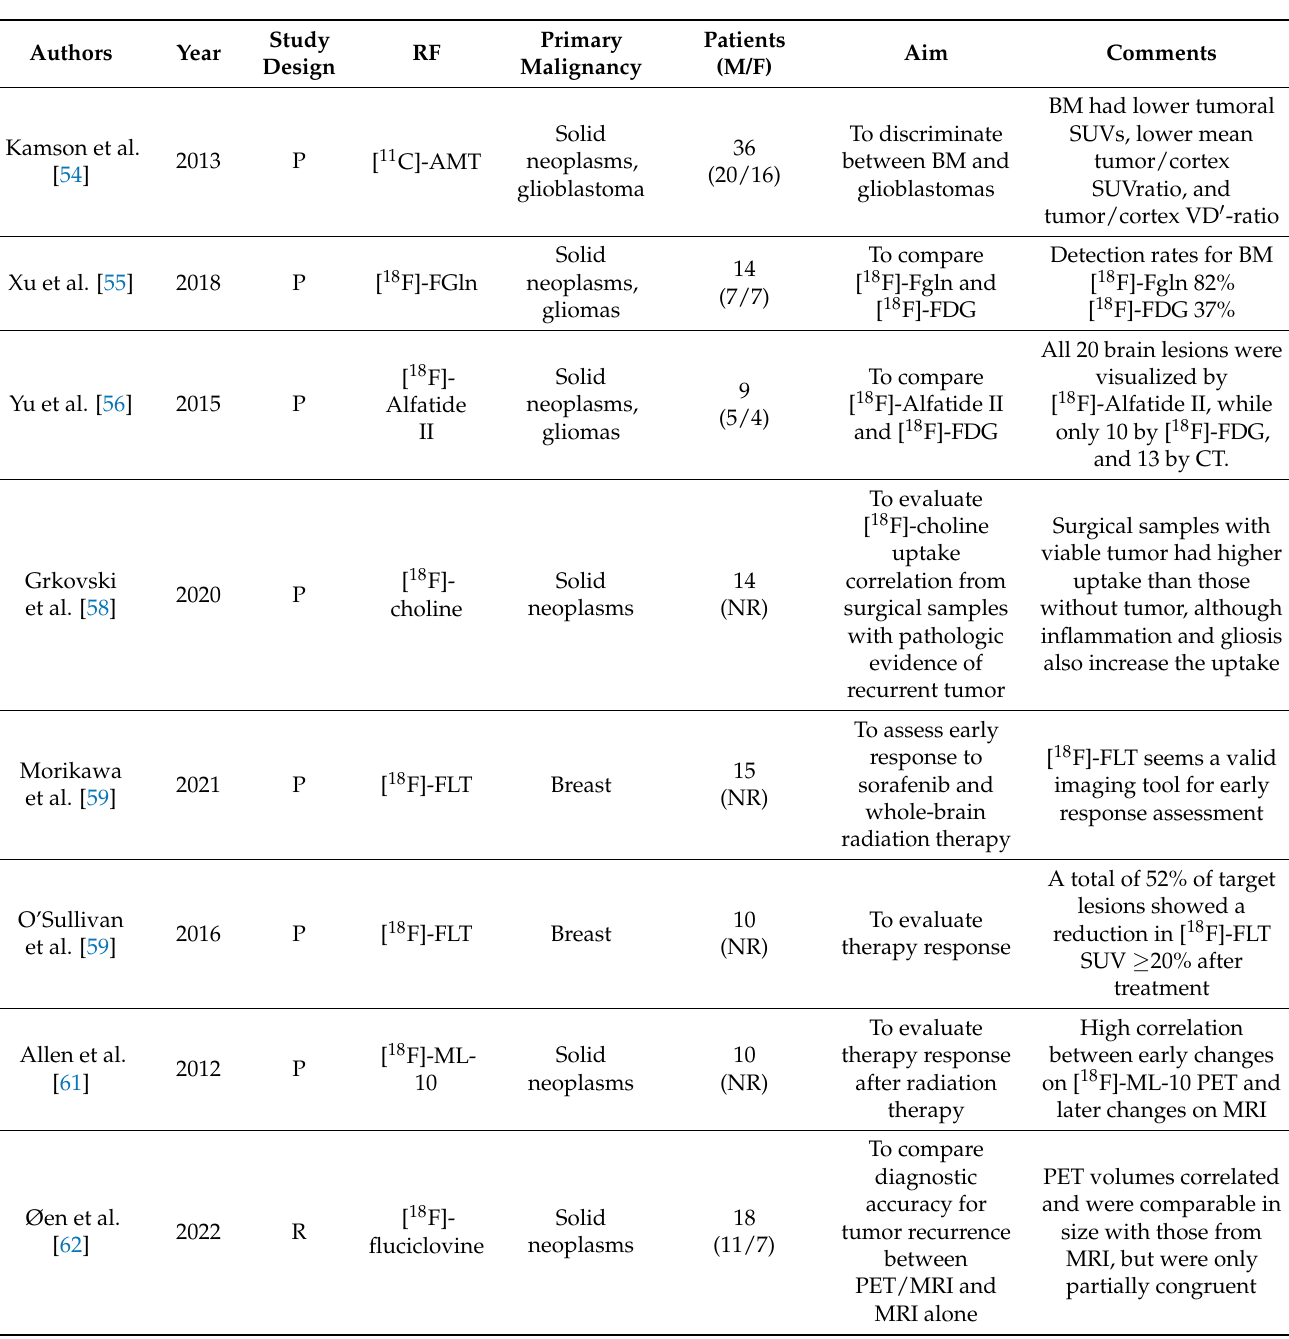
Table 3. Summary of general characteristics of studies with other